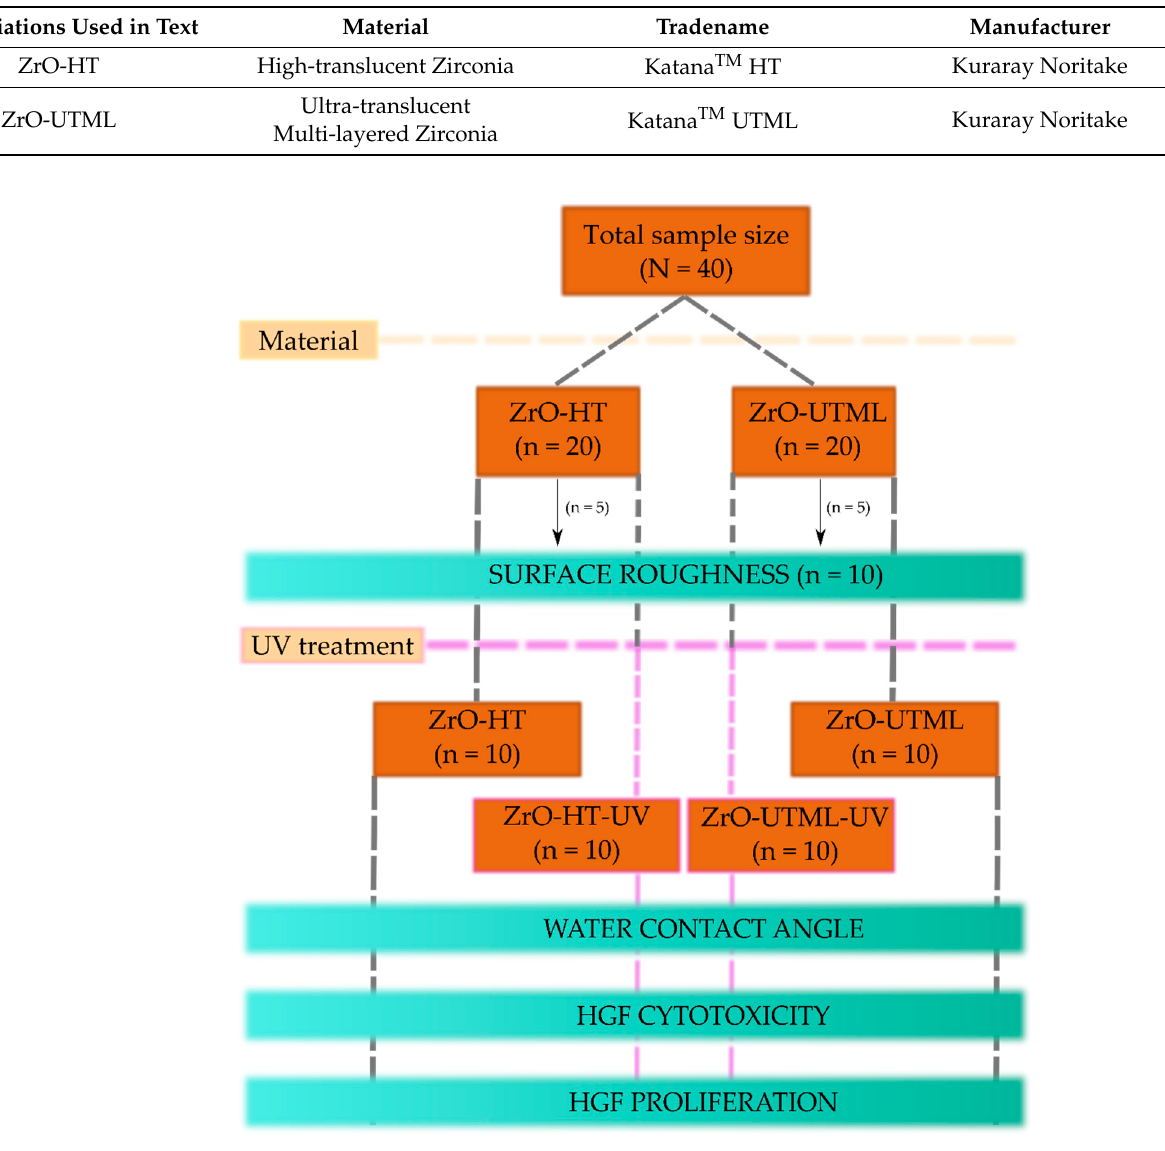
Figure 1. Study design scheme.